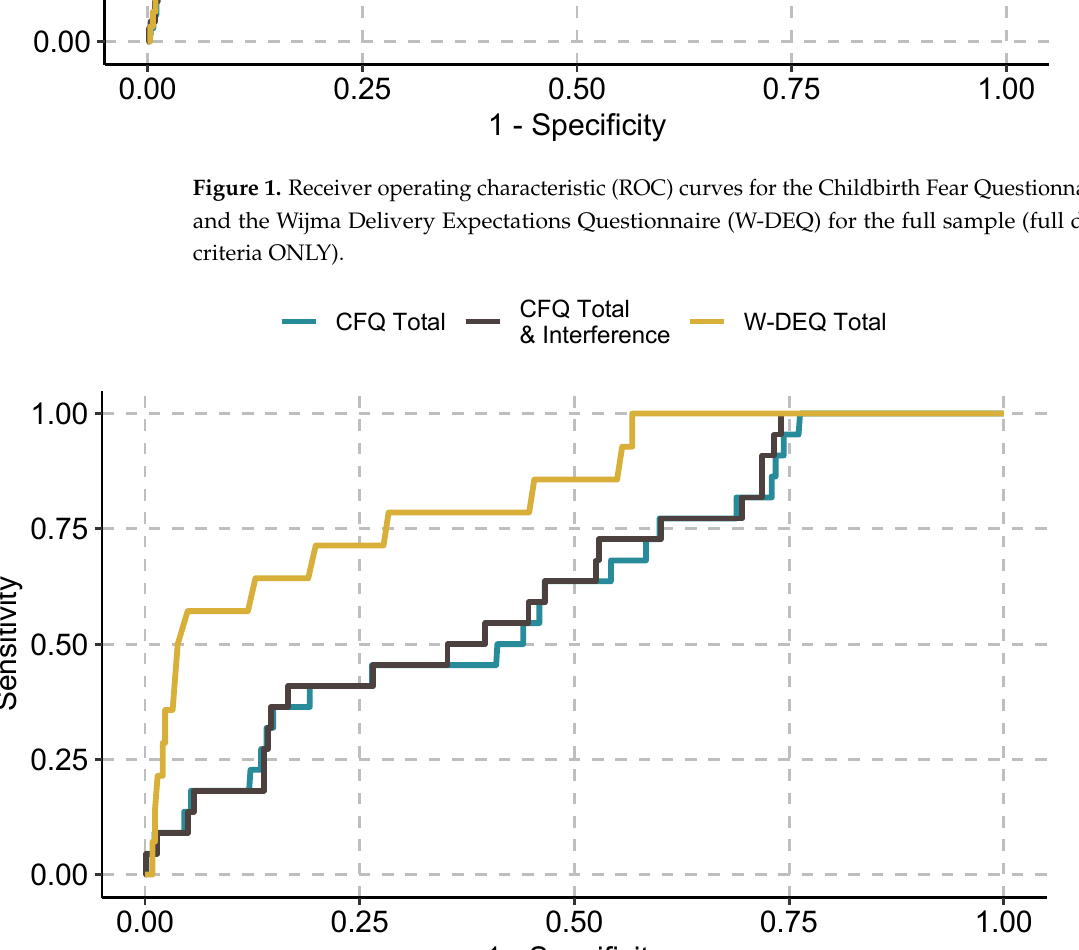
Figure 3. ROC curves for the CFQ (Total and Interference subscale scores) and the W-DEQ (subclinical and full diagnostic criteria combined).